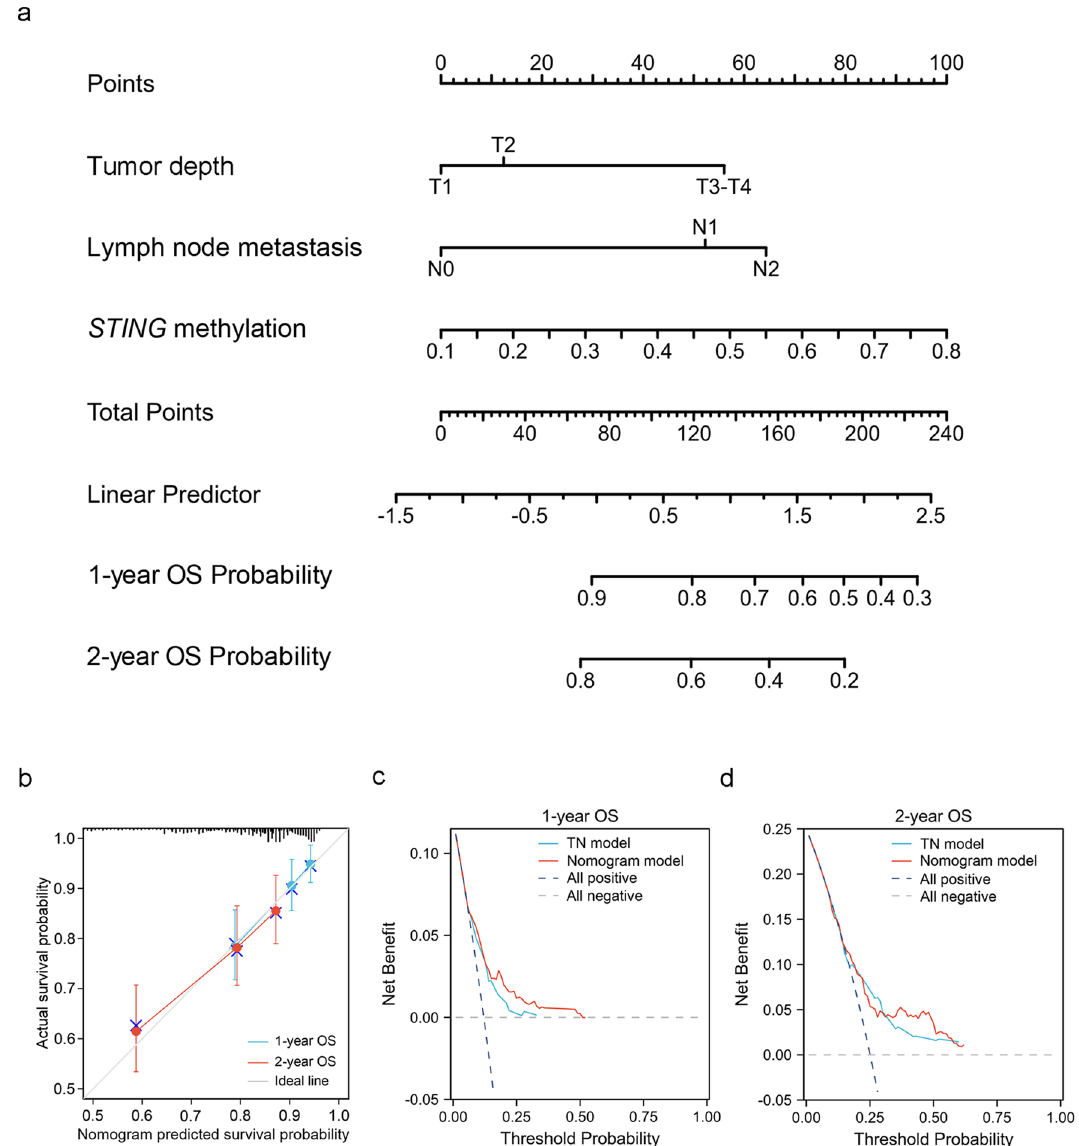
Figure 6. Construction and validation of the nomogram for 1- and 2-year OS of LUAD patients. ( a ) Construction of the prognostic nomogram for predicting the probability of 1- and 2-year OS in LUAD patients. The top straight line represents the points for each variable, and the total points were calculated by adding the points from each variable. A vertical line is drawn from the total point axis to the outcome axis to predict the probability of patients’ survival. ( b ) Calibration plots were generated to validate agreement between the predicted and actual probability of 1- and 2-year OS of LUAD patients. ( c , d ) The decision curves for the nomogram predicting 1-year ( c ) and 2-year OS of LUAD patients ( d ). The x-axis depicts the probability thresholds, while the y-axis depicts the net benefit. The all positive plot assumes that all patients reached the endpoint, whereas the all negative plot assumes that none of the patients reached the endpoint. T, tumor depth; N, lymph node